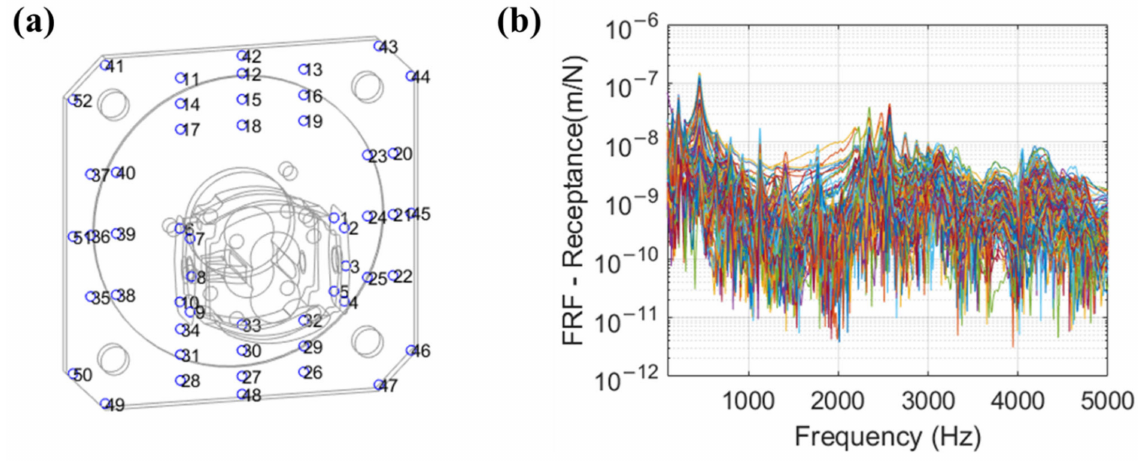
Figure 3. ( a ) Measurement points and ( b ) all measured FRFs with excitation at point